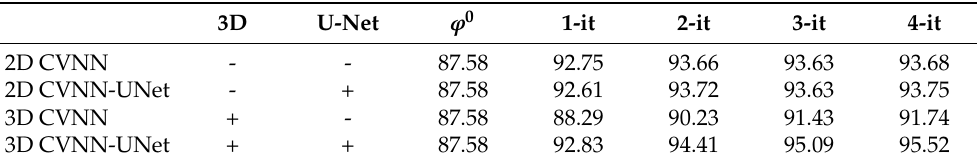
Table 3. Ablation results comparing 2D vs. 3D approaches and CNN vs UNet. The results are shown as average Dice scores obtained with 4-fold